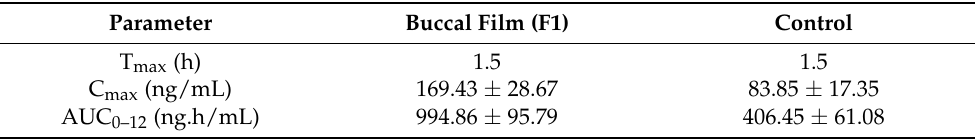
Figure 7. Mean plasma concentration–time profile of selected buccal film (F1) and control (oral solution of rizatriptan equivalent to 10 mg) in rabbits. Data represented are mean ± SD ( n = 6). * Statistically different at p < 0.005. Table 4. Pharmacokinetic parameters of rizatriptan in selected buccal film (F1) and control (oral solution of rizatriptan equivalent to 10 mg) in rabbits.